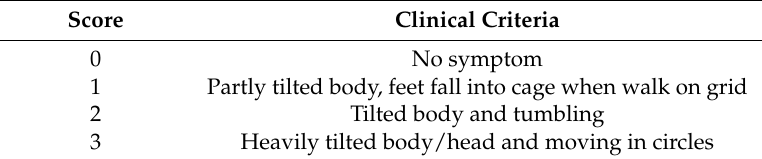
Table 2. Disease score determination criteria for the SJL/J-RR